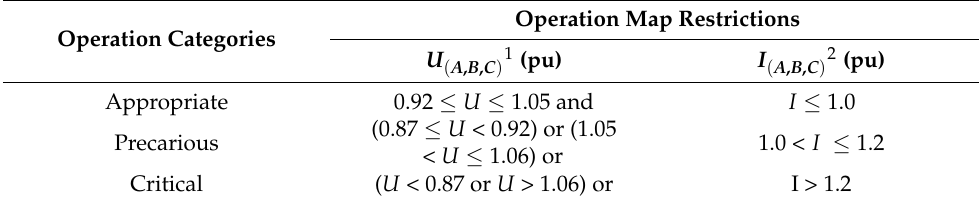
Table 2. Example of parameterization of the operation map.